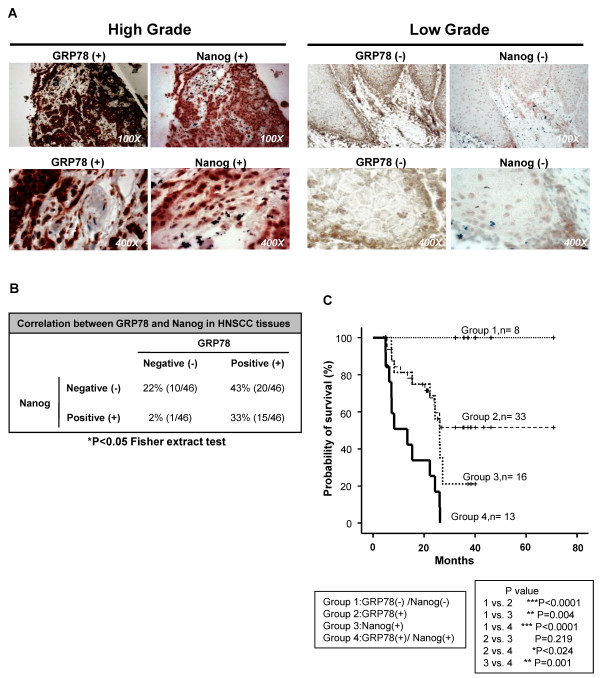
Co-expression of GRP78 and Nanog in HNSCC tissues. (A) Representative pictures of double positive (left panel) and double negative (right panel) in 46 HNSCC patient cases. Magnification was shown at lower right corner. (B) Statistical analysis of correlation betweenGRP78 and Nanog by Fisher extraction text. (C) Kaplan-Meier analysis of overall survival in HNSCC patients according to the expression of GRP78 and Nanog (Group1: GRP78(+)Nanog(+), Group2: GRP78(+), Group3: Nanog (+) and Group4: GRP78 (-)Nanog(-)).(*, p < 0.05; **, p < 0.01; ***, p < 0.001).